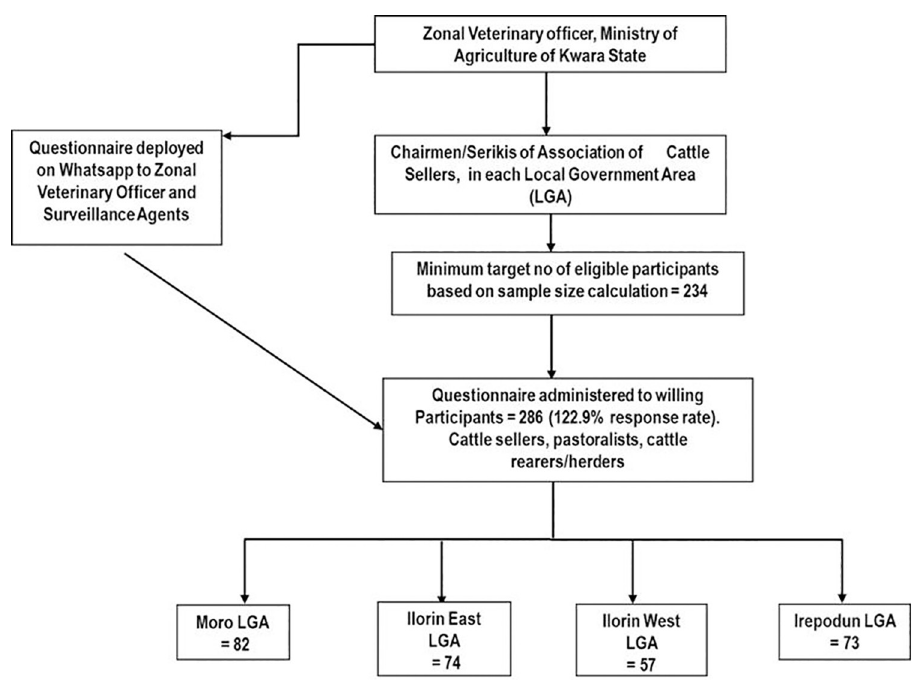
Fig 2. Recruitment flowchart for study